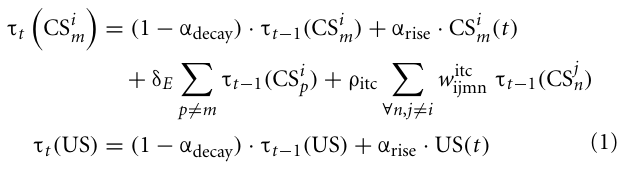
The same occurs for the other stimuli (R, “RED” and color